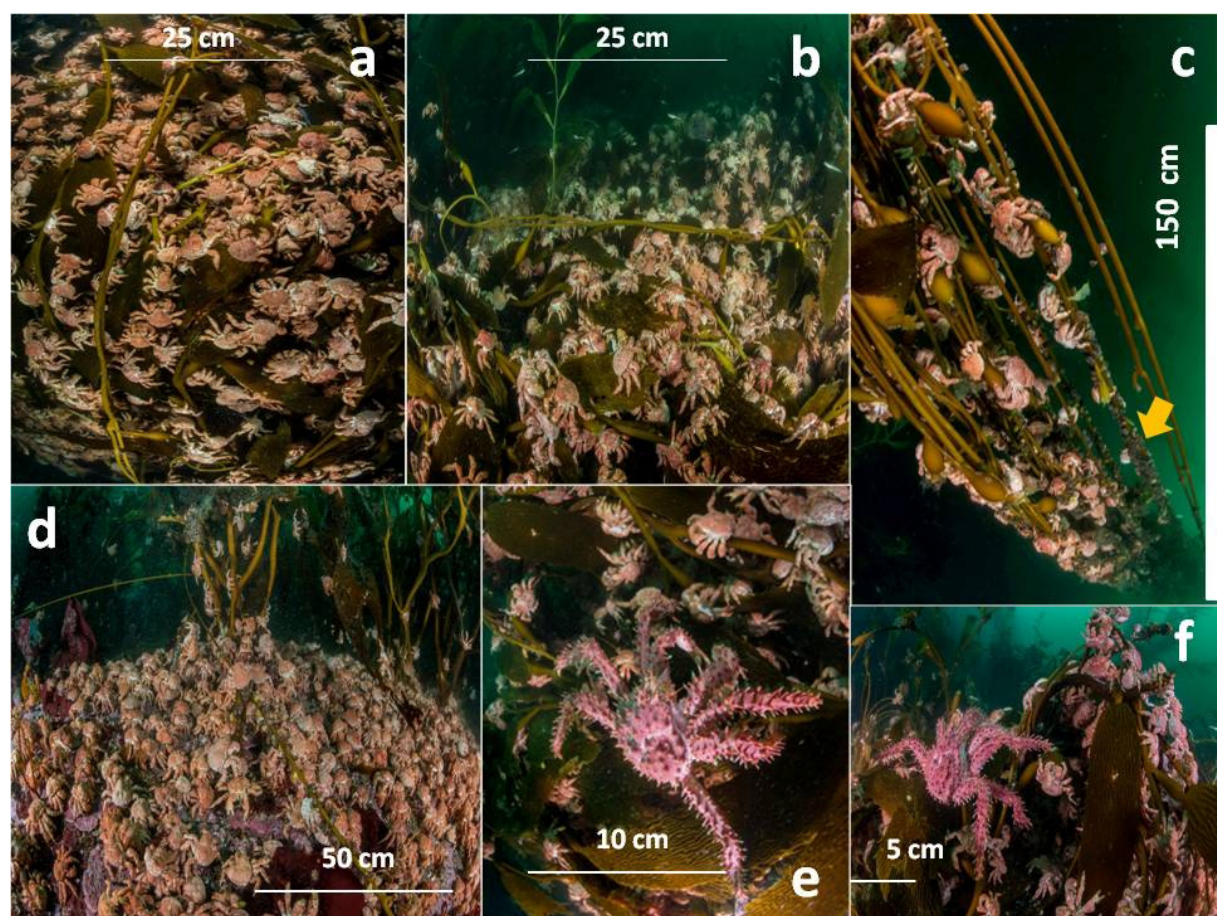
Figure 2. Podding of Paralomis granulosa (Lithodidae) juveniles on sub-Antarctic kelp: ( a–c, e, f ) Macrocystis pyrifera ; ( d ) Lessonia spp. All photographs were taken at the Wollaston Island, Cape Horn Archipelago, south of Chile (February 2017); c ) yellow arrow shows fouled plant of M. pyrifera with the bivalve Gaimardia trapesina , a possible prey of P. granulosa ; e, f ) large spiny crustaceans seen in each photo are adult king crab Lithodes santolla .